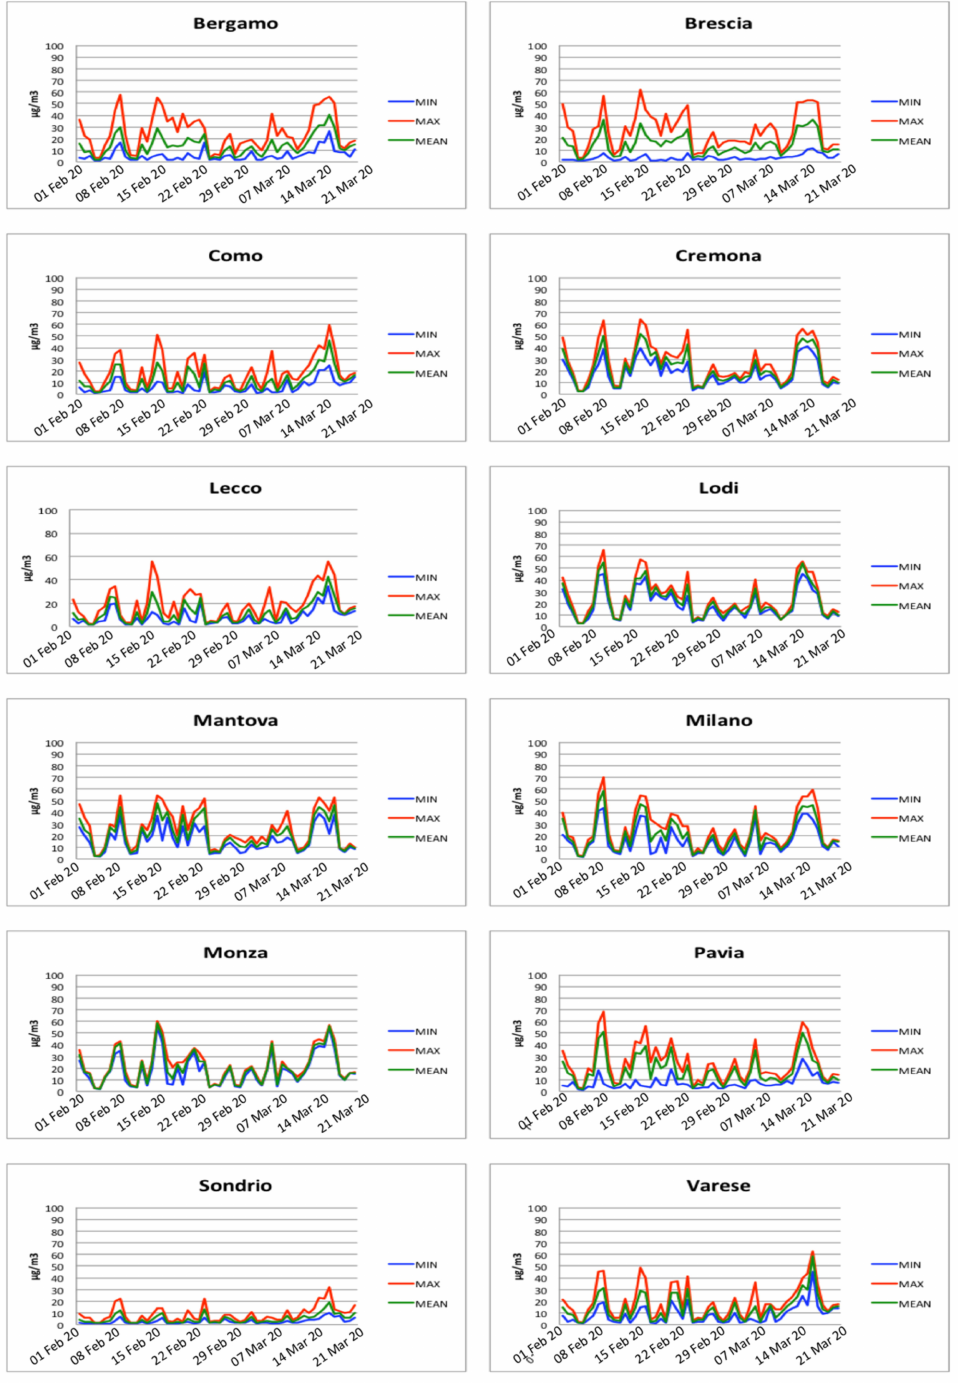
Figure 7. PM2.5 concentrations measured for each